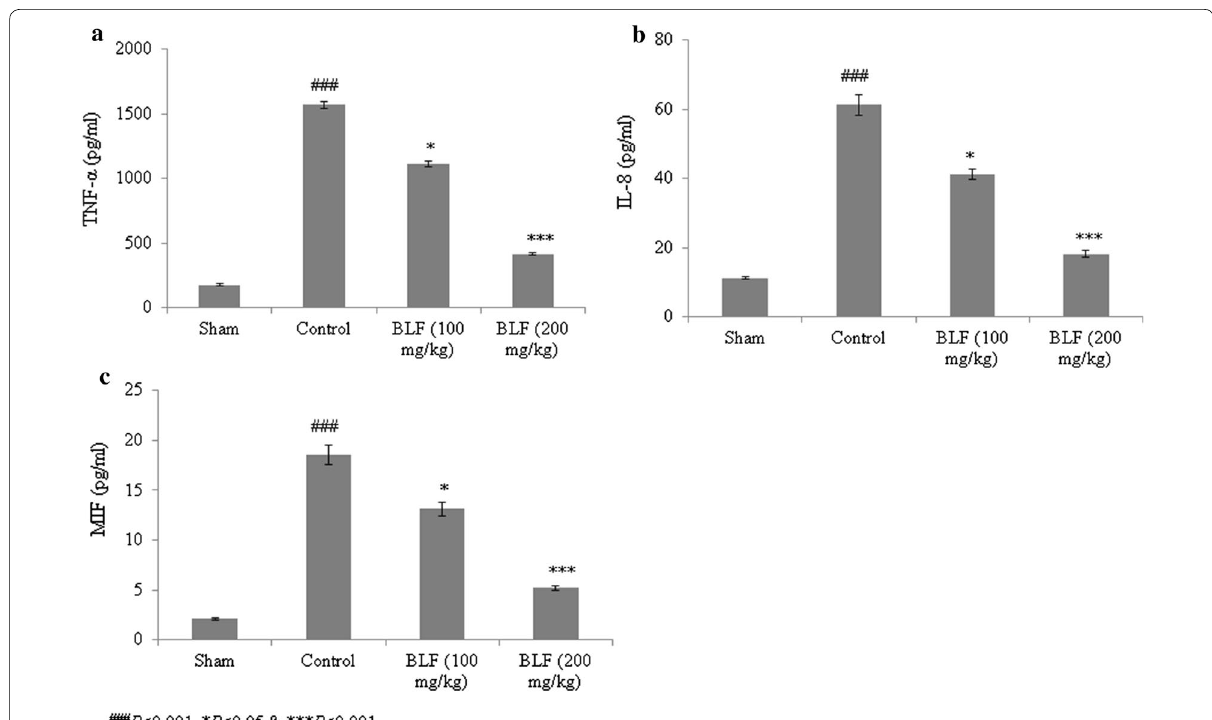
Fig. 6 BLF reduces tumor necrosis factor-alpha (TNF-α) ( a ), interleukin-8 (IL-8) ( b ) and migration inhibitory factor (MIF) ( c ) levels in ALI-induced male albino rats. Rats were given BLF for 30 consecutive days through oral gavage. ### P < 0.001 compared to the sham group; * P < 0.05 and *** P < 0.001 compared to control rats